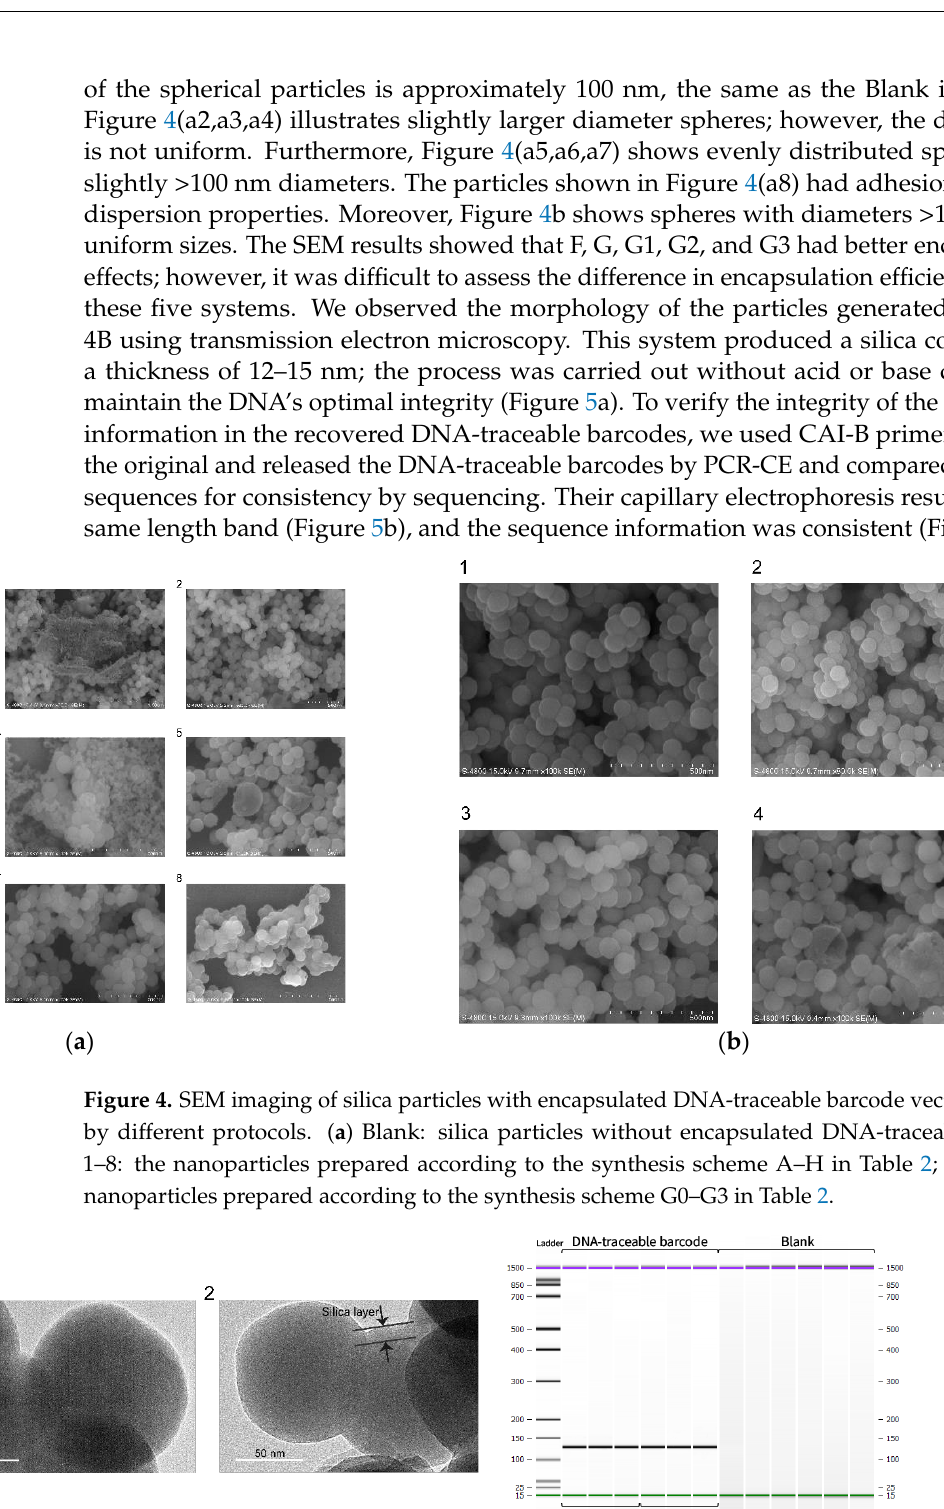
Figure 5. Characterization and identification of DNA-traceable barcode encapsulated silica parti- cles. ( a ) 1: Transmission electron microscopy image of SiO 2 particles without encapsulated DNA- traceable barcode. 2: Transmission electron microscopy image of DNA/SiO 2 particles. Scale bar, 50 nm. The silica layer has a thickness of 12 nm, and it protects the nucleic acid from ROS and heat. ( b ) Capillary electrophoresis graph obtained from plasmid DNA before encapsulation and after release from DNA/SiO 2 particles. Purple lines are upper marker, green lines are lower marker. Overall, we have developed a traceable barcode authentication method for various products that can be combined with various PCR procedures. Source accuracy and label compliance are critical concerns for regulators and consumers, particularly for GIs foods and HVP [37]. When the product is sold in the form of raw materials, the label of the DNA-